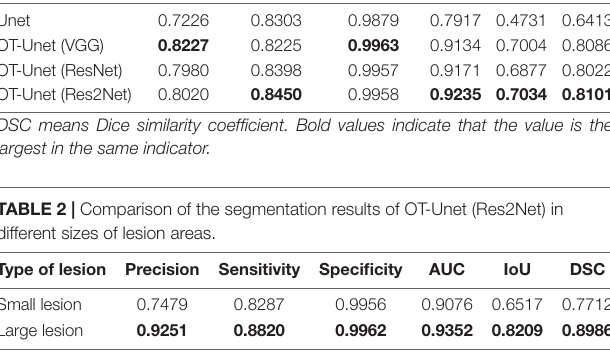
TABLE 1 | Comparison of segmentation results of different models. Methods